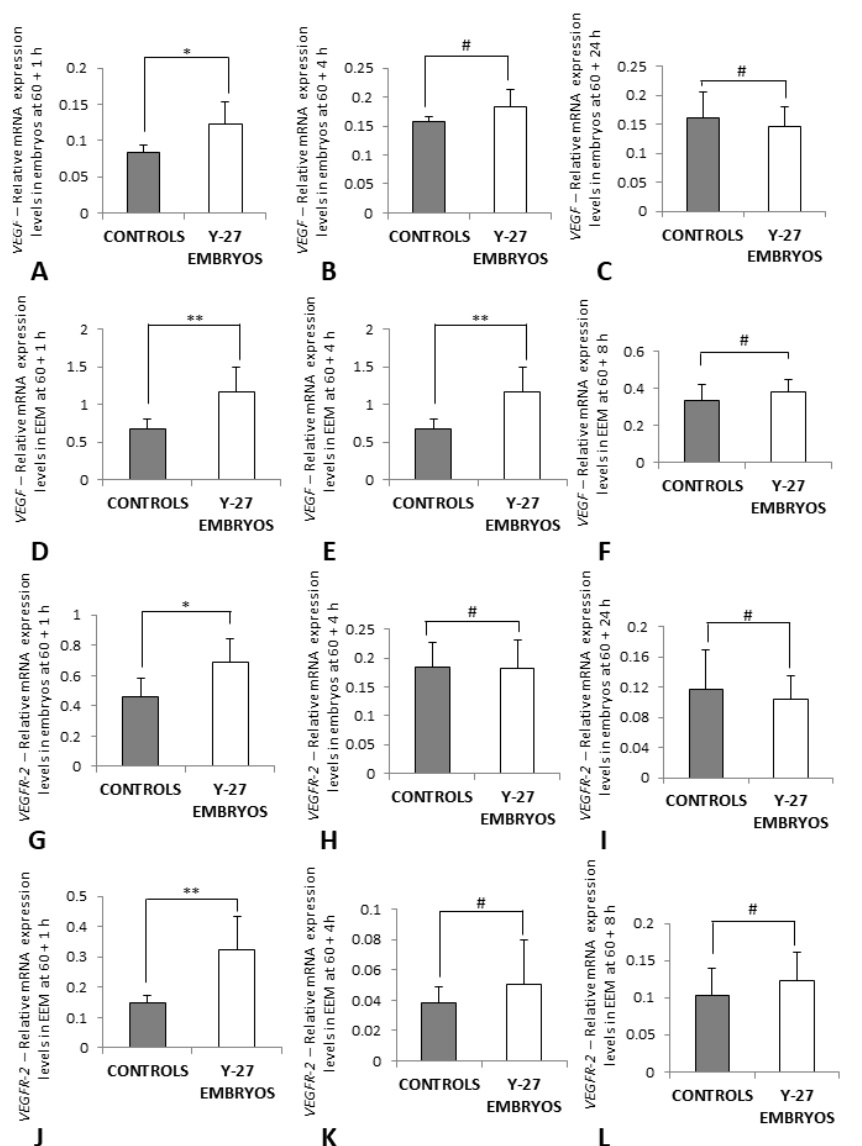
Figure 8. The relative mRNA expression levels of VEGF ( A – F ) and VEGFR-2 ( G – L ) in controls and embryos treated with Y-27632 (500 µM) at 60 h incubation. Embryos in ( A – C , G – I ), EEM in ( D , F , J – L ). The expression levels of VEGF and VEGF R-2 at 60 + 1 h were significantly higher in the treatment group when compared to controls ( A , G , * p < 0.05 and D , J , ** p = 0.009). The expression levels of VEGF and VEGFR-2 at other time points ( B , C , E , F , H , I , K , L ) were not different between controls and Y-27632-treated embryos (# p > 0.05). The vertical bars represent the SD. y -axis: Relative mRNA Expression Levels.